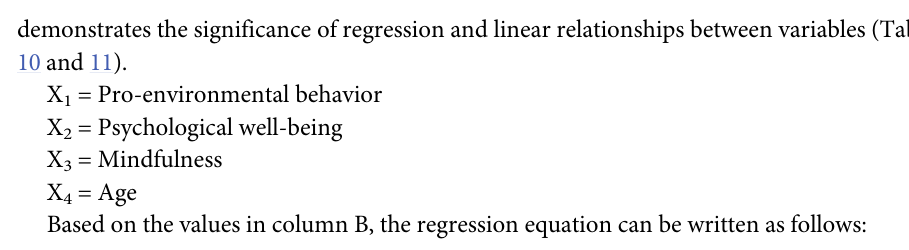
Based on the values in column B, the regression equation can be written as follows: